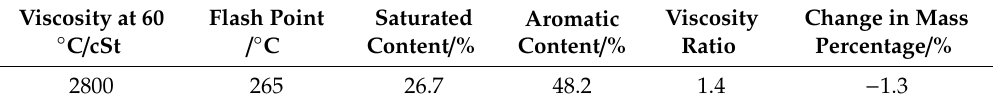
Table 5. Physical properties of Ding-bang rejuvenator.